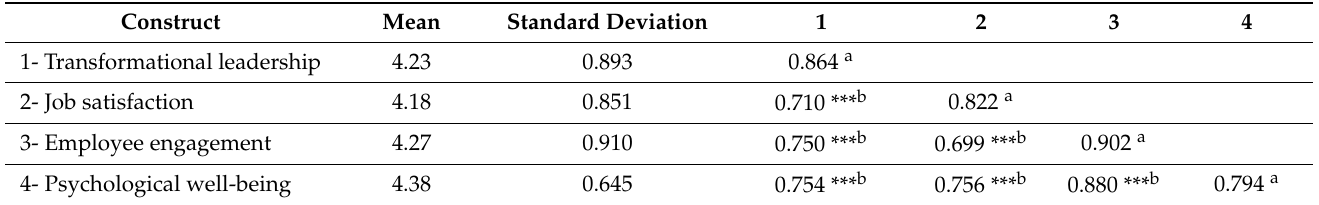
Table 3. Descriptive statistics and Fornell–Larcker method for discriminant